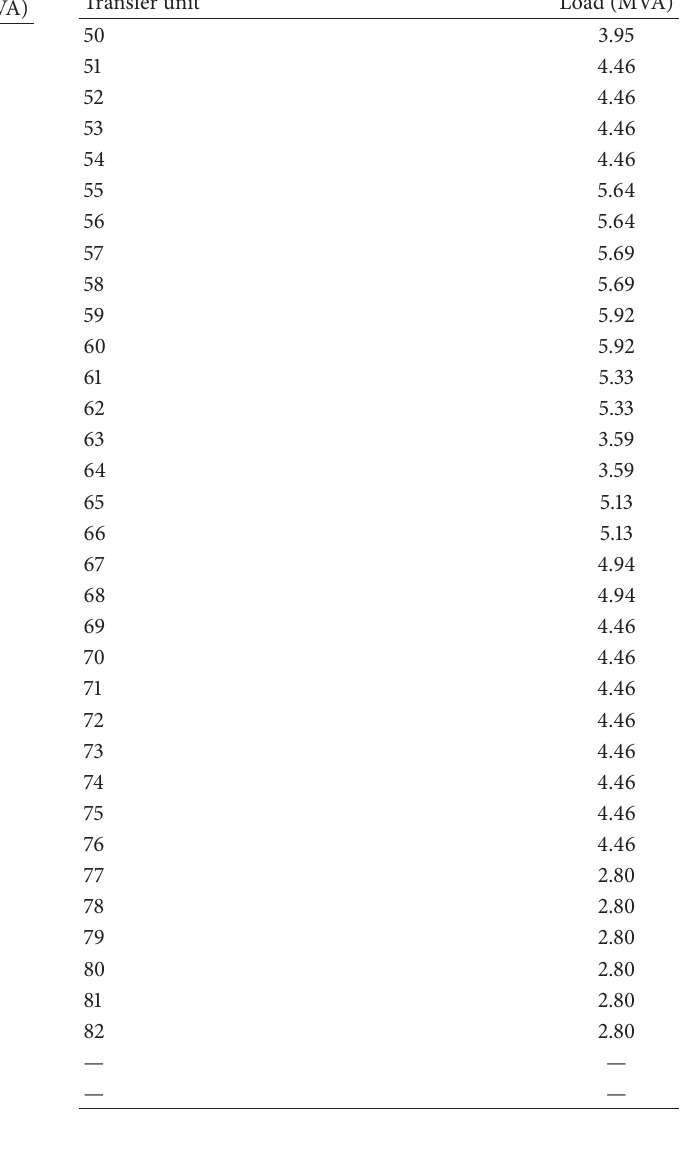
Table 2: Transfer unit load of W TSC in test case.